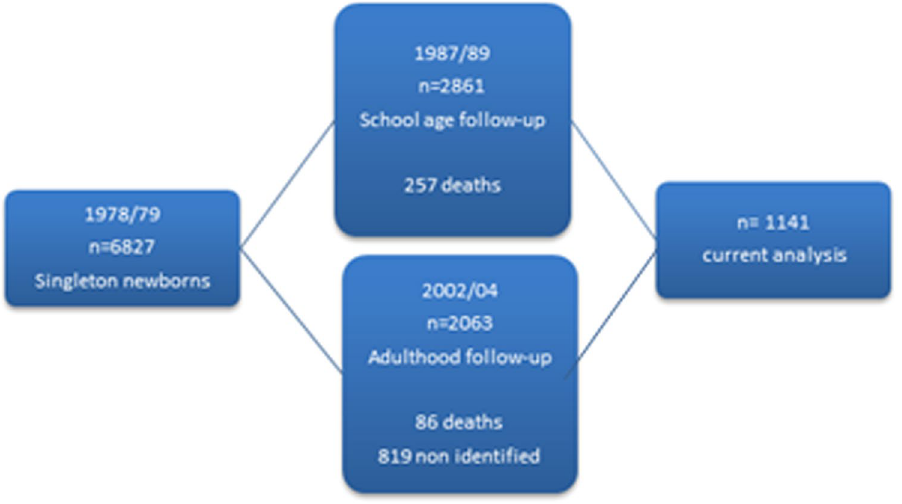
Figure 1. Flowchart of eligible population and sampling of the 1978/79 Ribeirao Preto birth cohort,